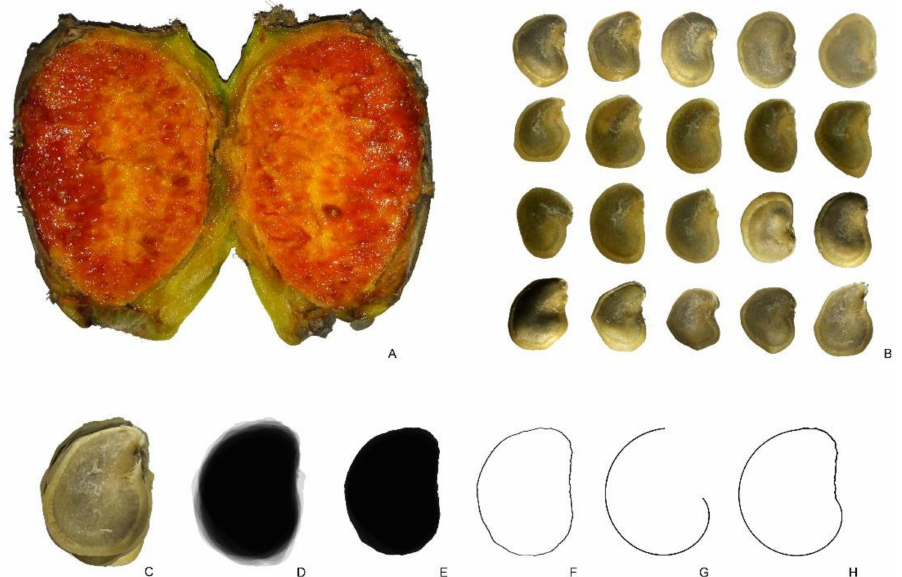
Figure 9. Seeds of Opuntia ficus-indica . ( A ) Open fruit. ( B ) Twenty seeds. ( C ) The images of twenty seeds were superimposed ( C ) and converted to their silhouettes ( D ) to obtain the average silhouette ( E , F ). ( G ) The geometric figure used as the basis for the model corresponds to the repre- sentation of the equation r = t − 1 + 1 − cos ( t ) with t ∈ [ 2,6 ] . ( H ) Composed model with part of the average silhouette and part of the geometric figure. Bar equals 1